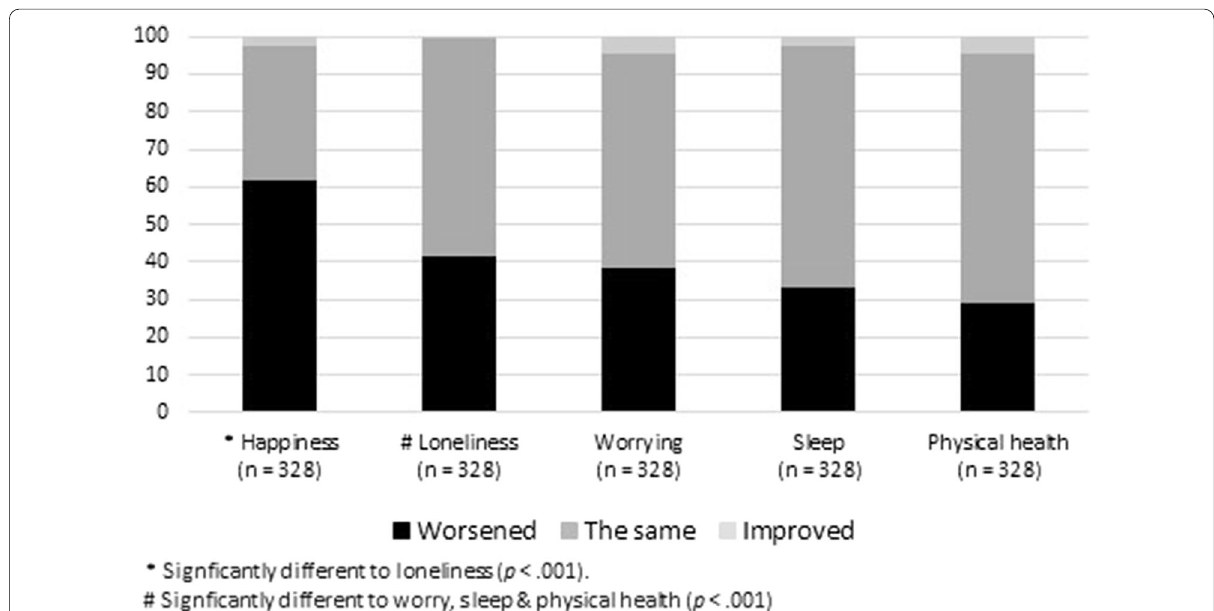
Fig. 5 Percentage of participants reporting face mask use by other people was very or somewhat influential on their quality of life ( n reported a worsened, the same, or improved impact on five aspects of quality of